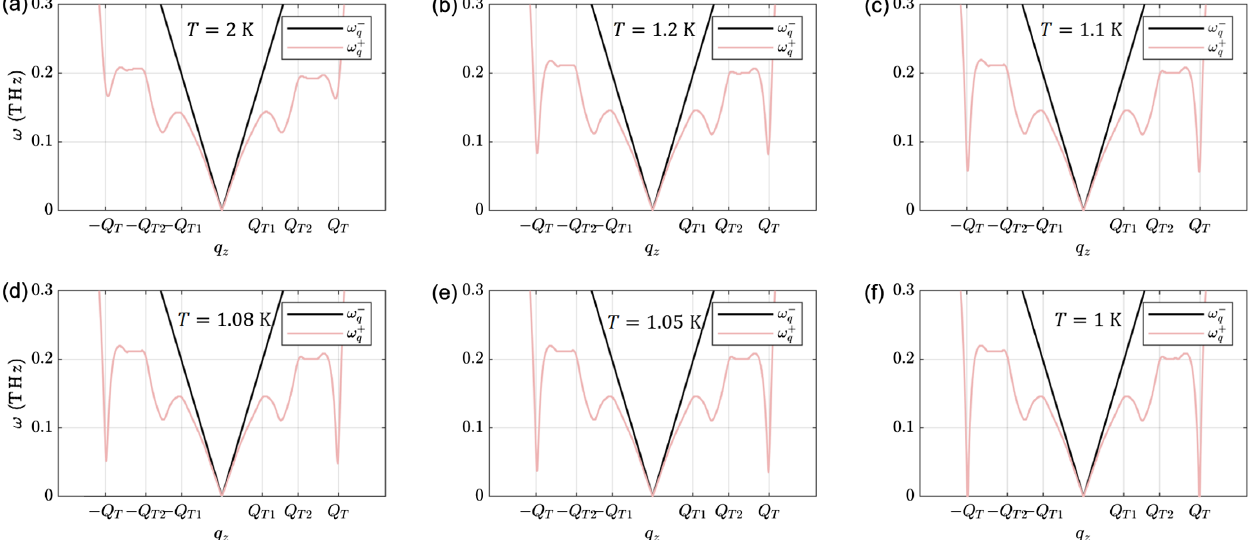
FIG. 6. Phonon frequencies of Kramers-Weyl semimetal under B ¼ 10 T magnetic field at different